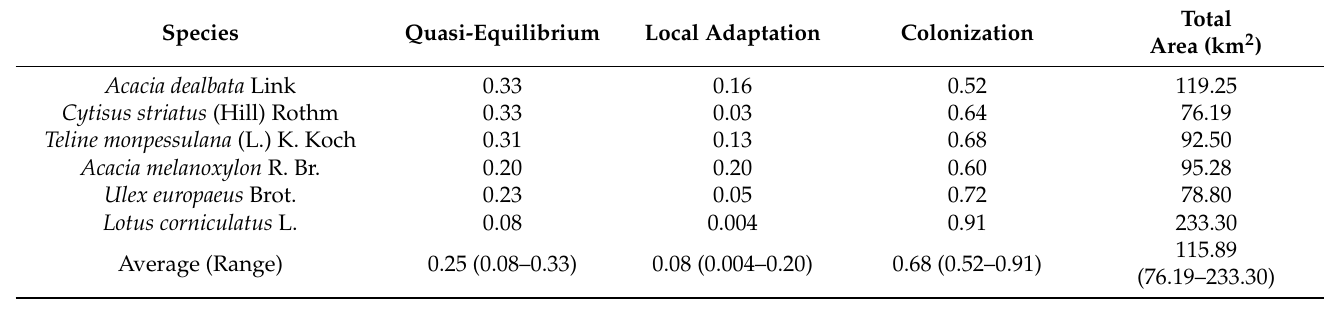
Table 2. Proportion of predicted area by regional and global models for the three invasive stages proposed by [14] for six alien leguminous species.